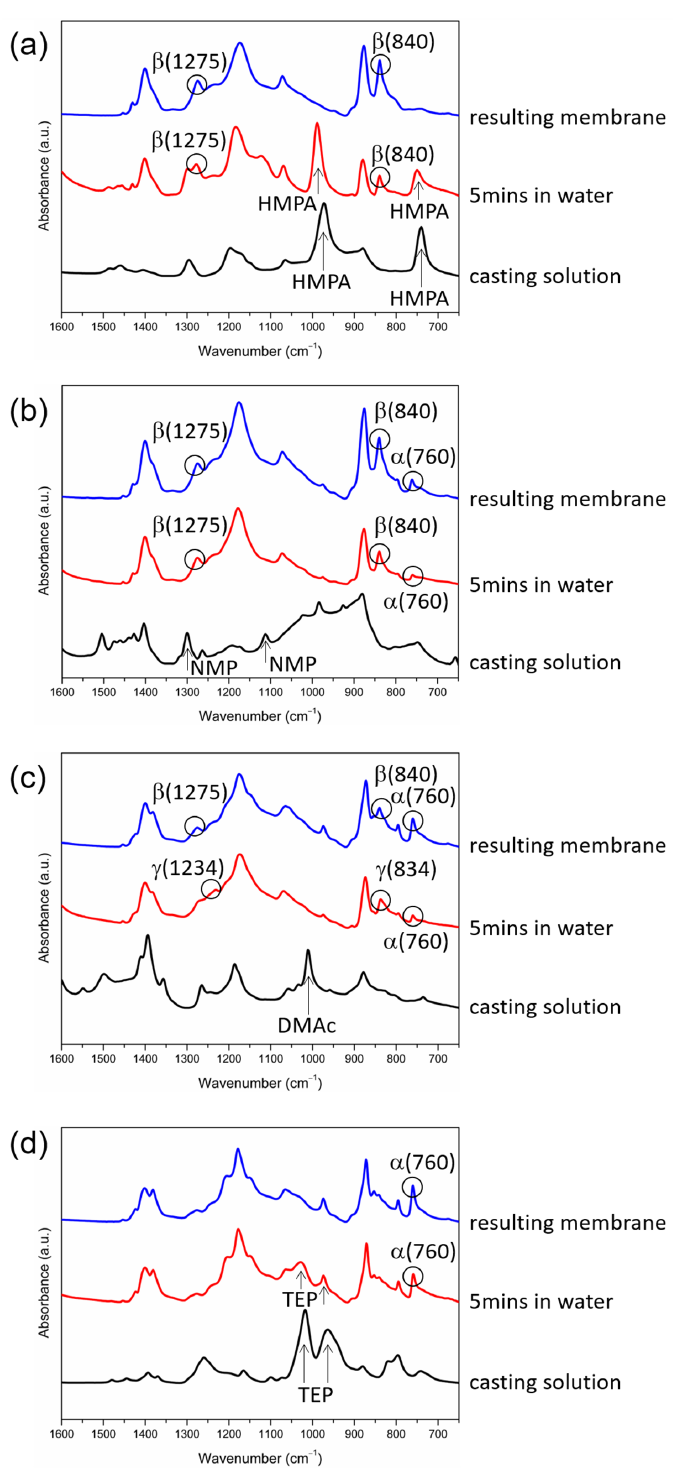
Figure 6. FTIR/ATR spectra of the surfaces of PVDF cast films at three time points during membrane formation (immediately after the solution casting, after 5 min in water, and after the membranes were formed) with HMPA ( a ), NMP ( b ), DMAc ( c ) or TEP ( d ) as the solvent.